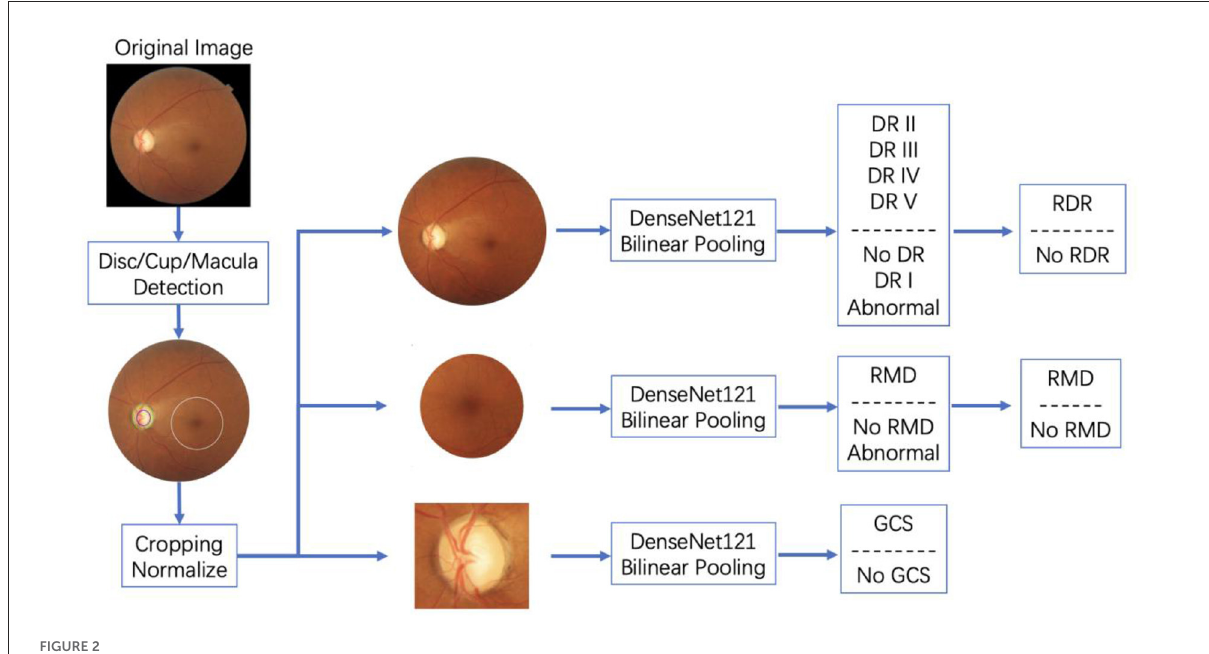
FIGURE2 Details of disease prediction modules in AI-100.